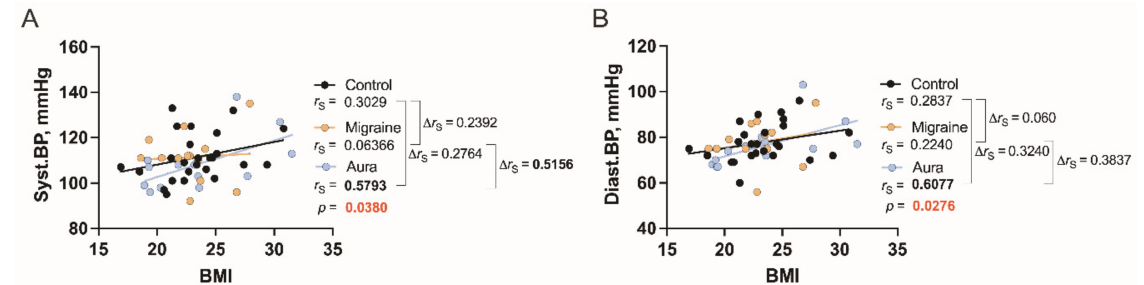
Figure 2. The relationship between BMI and BP (( A ) systolic BP, ( B ) diastolic BP) in healthy in- dividuals (control) and in patients with migraine without aura (migraine) and with aura (aura). r S : Spearman’s rank correlation coefficient, ∆ r S : difference of coefficients.